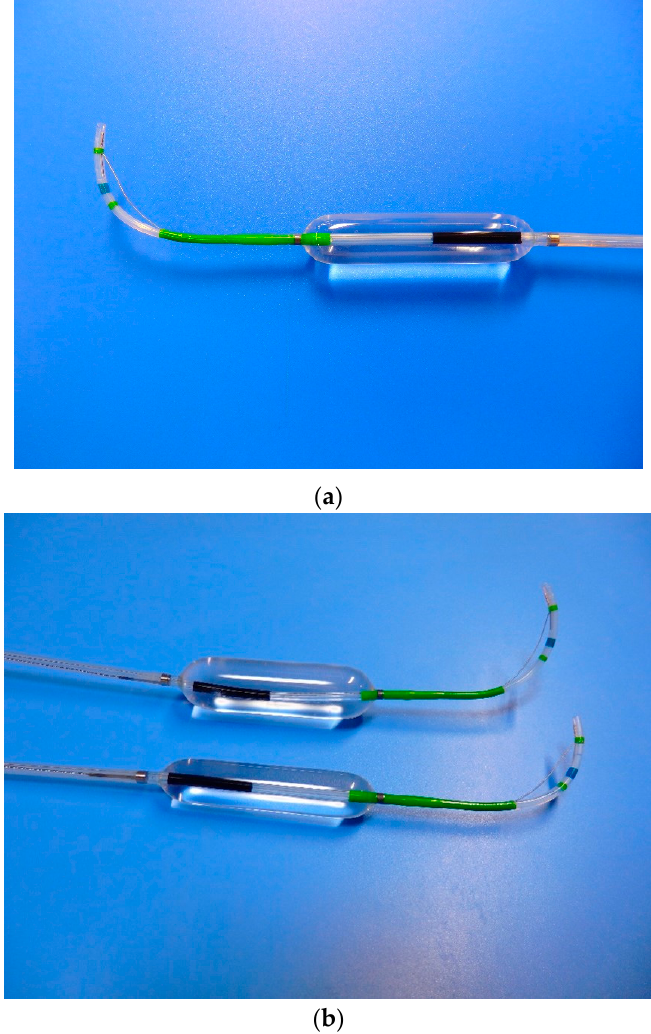
Figure 4. ( a ) A device integrating a sphincterotome and a balloon (StoneMaster V; Olympus Corp., Tokyo, Japan). ( b ) Two types of balloon sizes that can be used for ESBD and ESLBD. ESBD, endoscopic papillary balloon dilation with endoscopic sphincterotomy; ESLBD, endoscopic papillary large balloon dilation with endoscopic sphincterotomy.